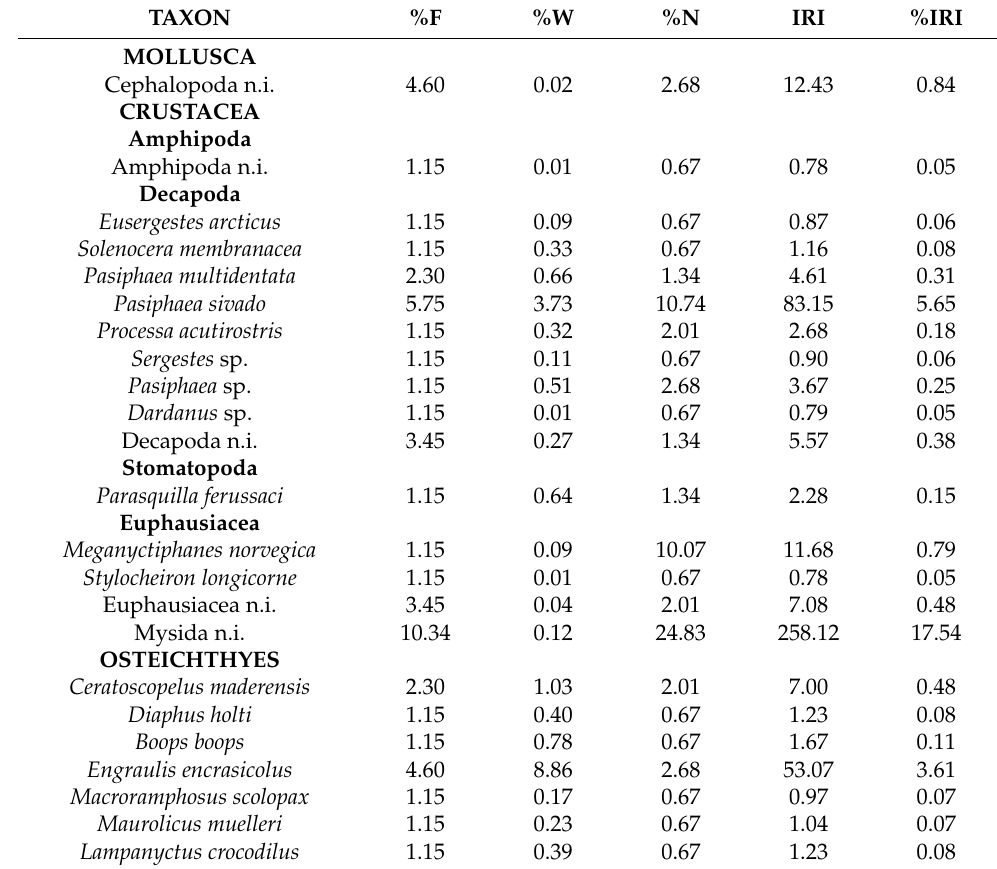
Table 7. Diet composition of the whole hake series from southern and central Tyrrhenian Sea sampled in 2020. In the columns are reported the diet index values (%F, %W, %N, IRI and %IRI) for each prey category.